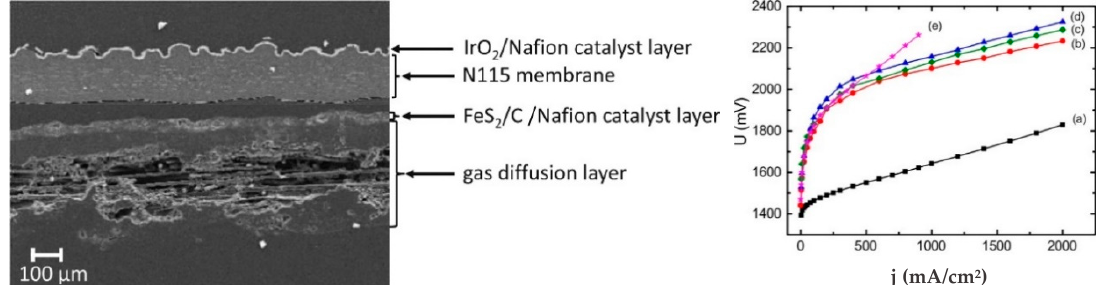
Figure 10. ( left ) SEM image of the cross section of the MEA IrO 2 /Nafion/pyrite FeS 2 ; ( right ) Polarization curves at 80 °C and atmospheric pressure with (a) Pt/C ‐ based MEA (black squares), (b) pyrite ‐ based MEA (red dots), (c) greigite ‐ based MEA (green diamonds), (d) pyrrhotite ‐ based MEA (blue triangles) and (e) selected carbon ‐ only ‐ based MEA (magenta stars). Reprinted with permission from [145]. Copyright 2018 American Chemical Society.